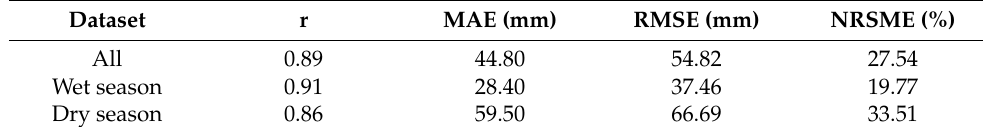
Table 1. Validation performance of monthly PET from four locations.